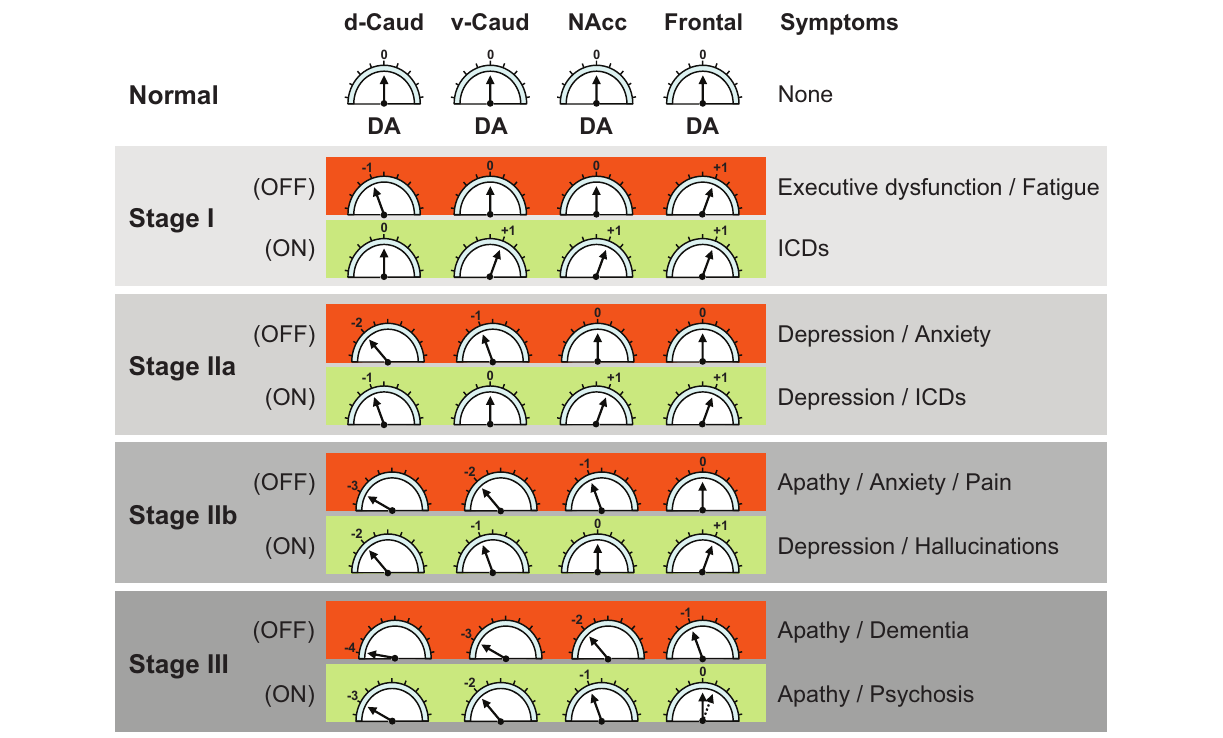
FIGURE 2 | Parkinson’s disease related frontostriatal cognitive dysfunction (PDFCD) staging with region-specific dopaminergic (DA) tone . Predicted stage-specific DA function, both “off” and “on” medication (OFF and ON), is shown for dorsal caudate (d-Caud), ventral caudate (v-Caud), nucleus accumbens (NAcc), and frontal cortex. Although no distinction is made between the frontal regions corresponding to the different frontostriatal cognitive loops (i.e., dorsolateral prefrontal cortex, orbitofrontal cortex, and